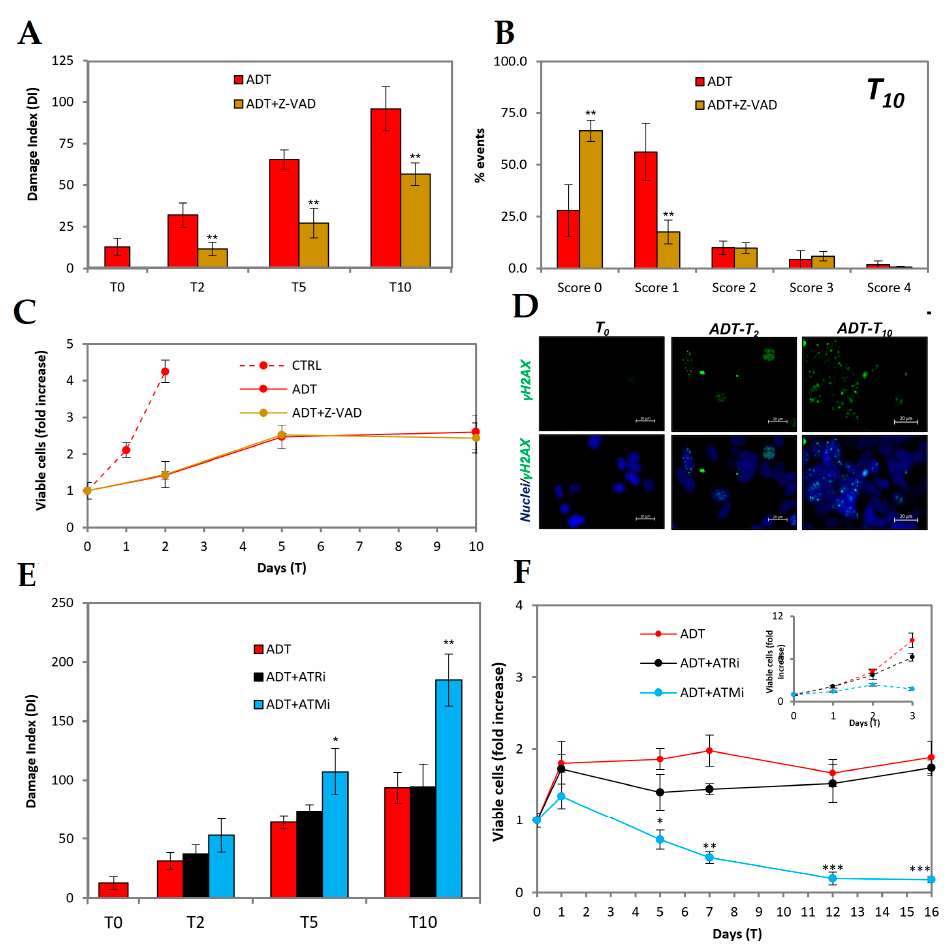
Figure 3E, by comet assay. On the contrary, the inhibition of ATM and RAD3-related (ATR), the kinase coordinating response and the single-strand (ss) DNA breaks repair, does not interfere with ADT-induced DNA damage.